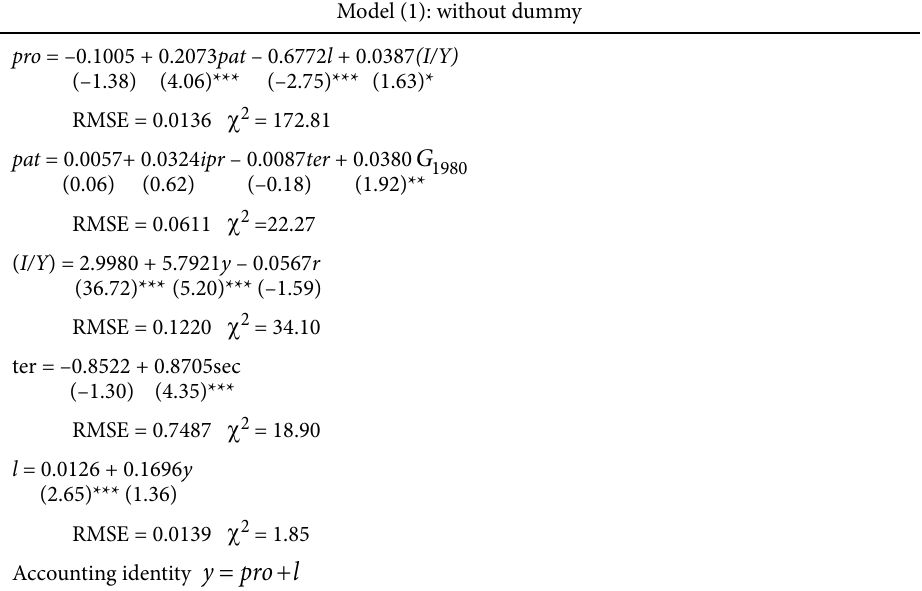
Table 3. Estimation of the simultaneous-equations